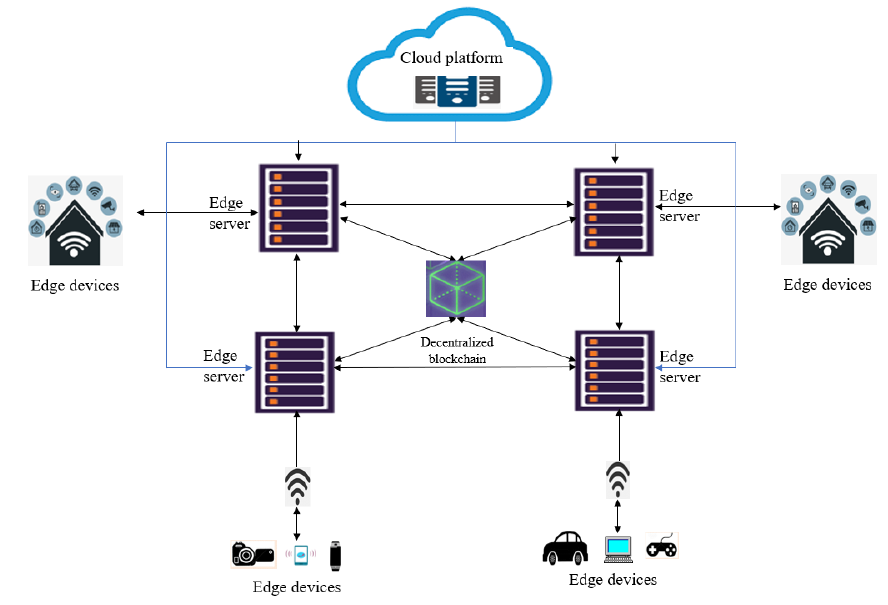
Figure 3. Architecture of this proposed